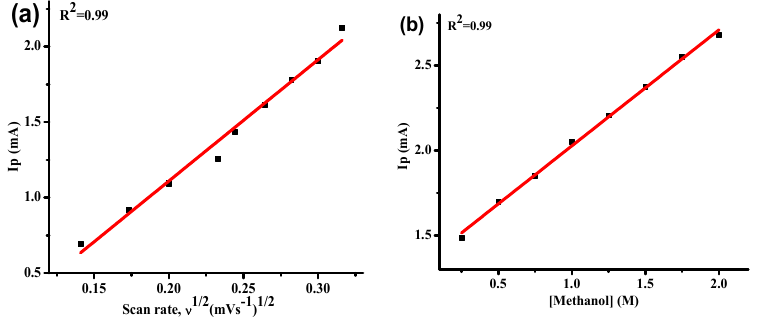
Figure 7. Cyclic voltammograms using equiatomic (Al, Fe, Mg, Cd, Cr, Mn) 3 O 4 ( a ) and non- equiatomic [Al 35 (Fe, Mg, Cd, Cr, Mn) 65 ] 3 O 4 electrodes ( b ) in 1M KOH at 100 mV s −1 showing variation in peak current with increasing the methanol concentration.